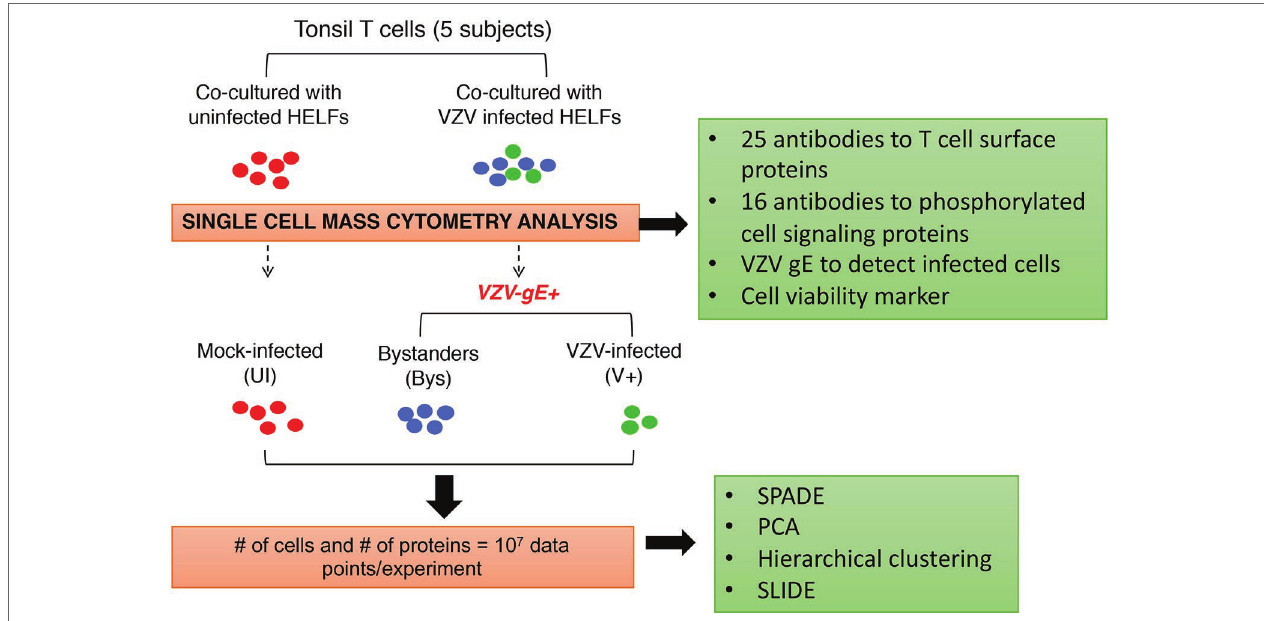
FIGURE 3 | Experimental approach for analysis of VZV infection of T cells at the single cell level. Primary human tonsil T cells were isolated from tonsils collected from patients undergoing tonsillectomy. The T cells were purified from other immune cell types by negative selection and were exposed to virus infection by co- culturing with infected primary fibroblasts [human embryonic lung fibroblasts (HELFs)]. T cells were also co-cultured with mock-infected fibroblasts (mock infection) to control changes in T cells associated with co-culturing. The mock- and VZV-infected T cells were collected, fixed at 48 hpi, and stained using a cocktail of antibodies against a predefined set of host cell surface and intracellular signaling targets. T cells containing virus were identified by glycoprotein E (gE) expression (green) and distinguished from non-gE expressing “bystander” cells (blue), which were exposed to infected fibroblasts but did not become infected by VZV. For all downstream analysis, the VZV-infected (gE expressing) cells were compared to the “bystander” and mock-infected cells, both of which were controls for recording changes, specifically introduced by VZV. Several analytical algorithms including spanning-tree progression analysis of density-normalized events (SPADE), principal component analysis (PCA), hierarchical clustering, and single cell linkage using distance estimation (SLIDE) were applied in this study. Adapted from Sen et al.